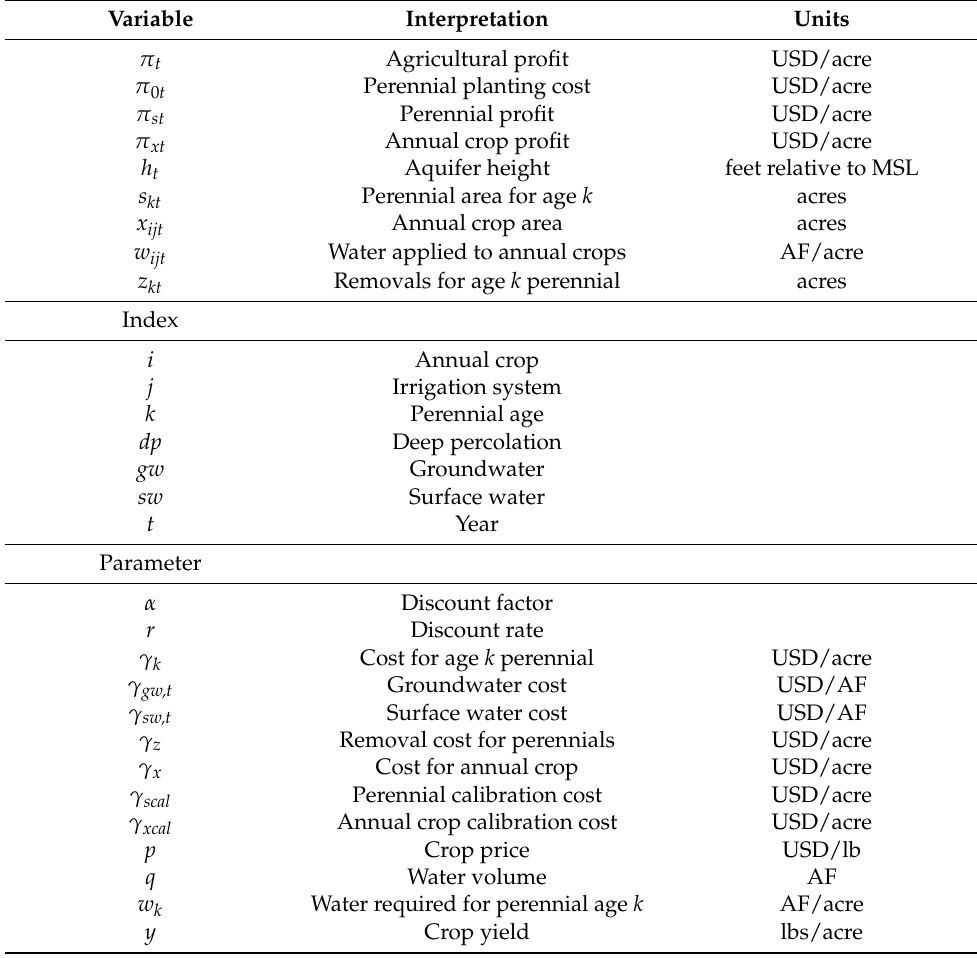
Table 3. Key model